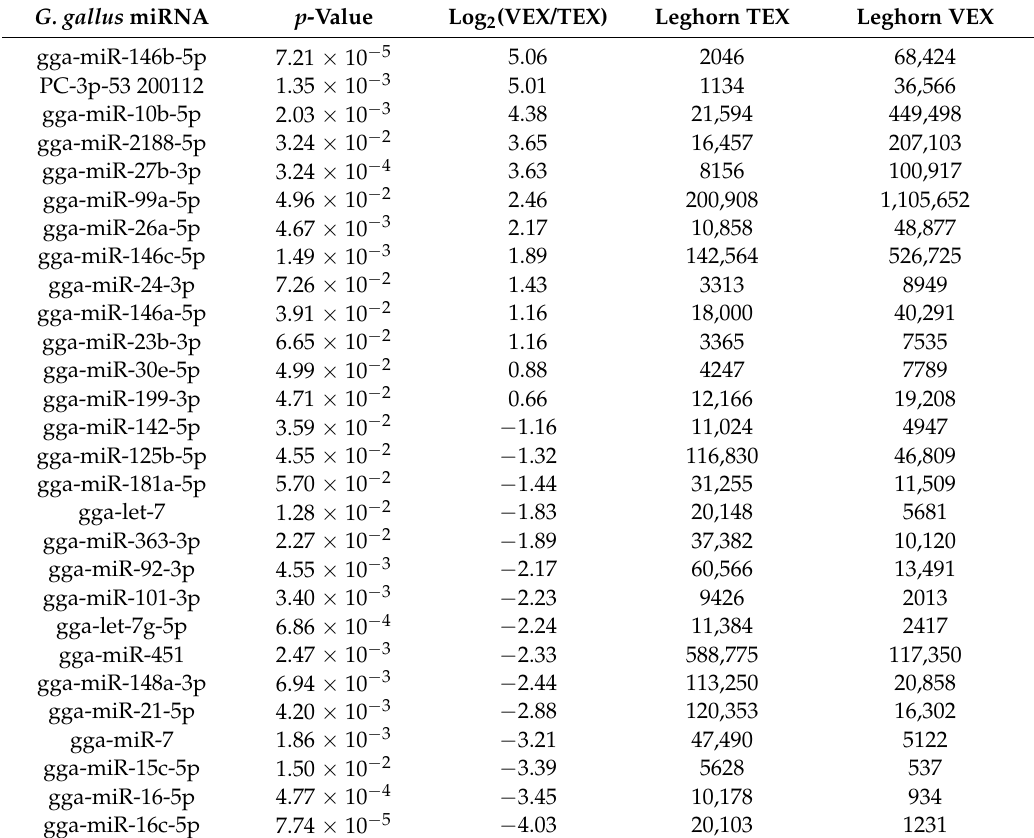
Table 2. Gallus miRNA read counts and miRNA abundance in leghorn VEX and TEX. G. gallus